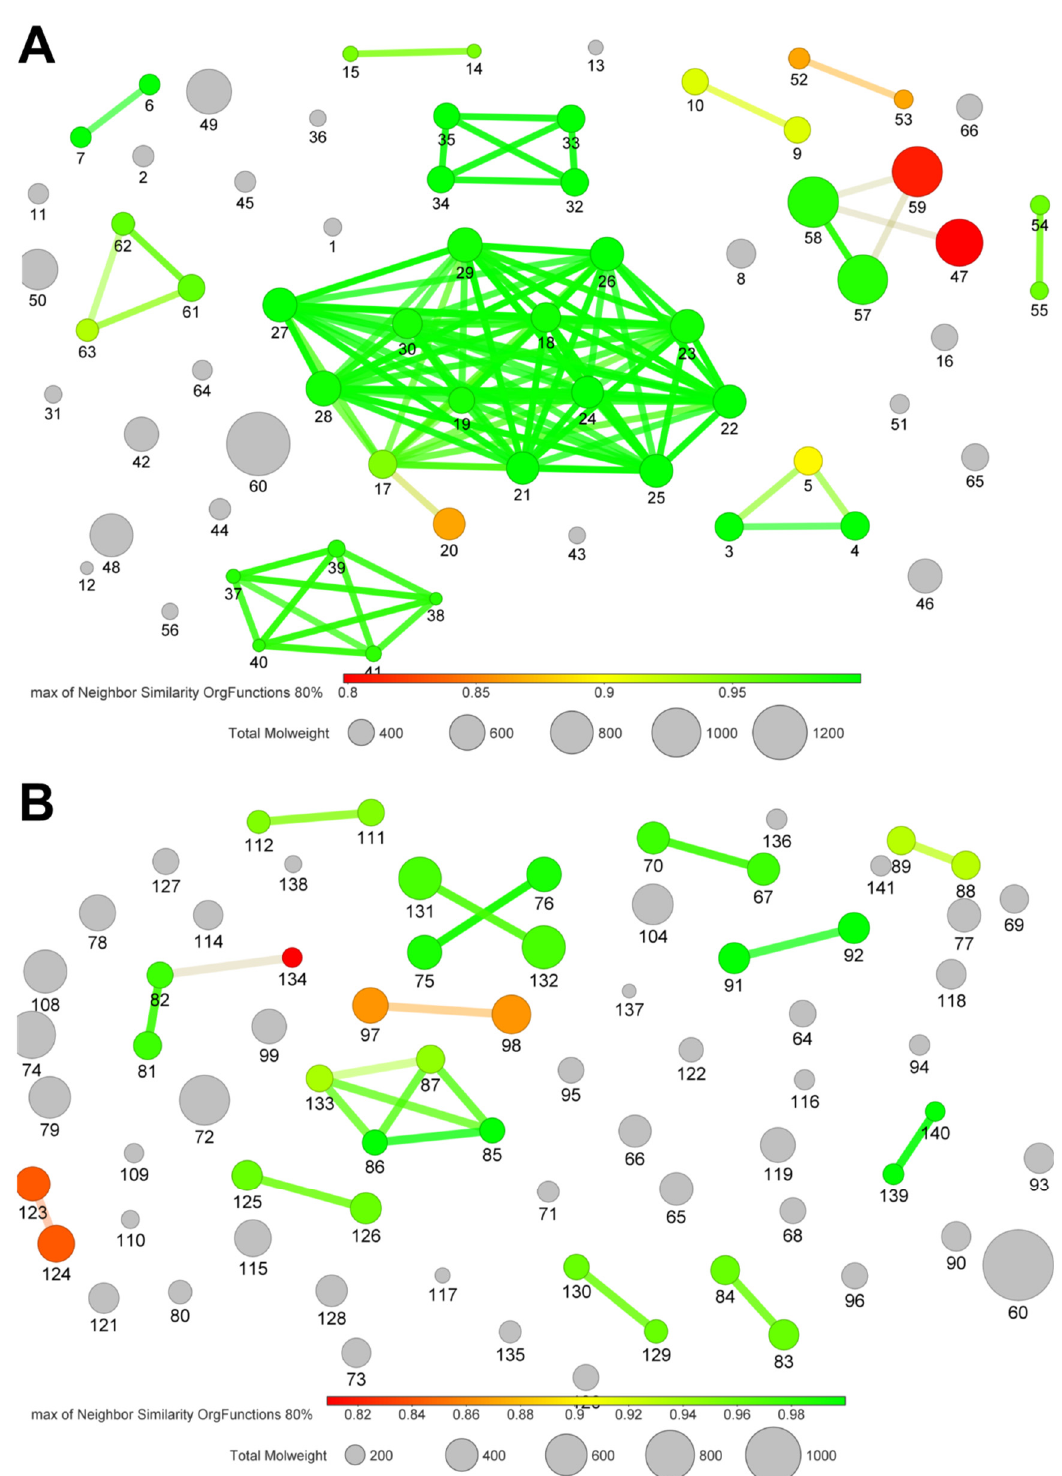
Figure 7. Similarity analysis of anti-inflammatory and antioxidant Streptomyces -derived metabolites. The similarity analysis was performed using the OrgFunctions descriptor. The color scale bar indicates the level of similarity from red (0.8) to green (1.0). Each marker size indicates molecular weight (g mol − 1 ). ( A ) Compounds with anti-inflammatory activity. ( B ) Compounds with antioxidant capacity. Each metabolite in the compound library was classified as alkaloids, amides, phenylpropanoids, polyketides, flavonoids and terpenoids based on the elemental units identified in the molecular structure. Since compounds 52 and 53 showed mixed elemental units between phenylpropanoid and